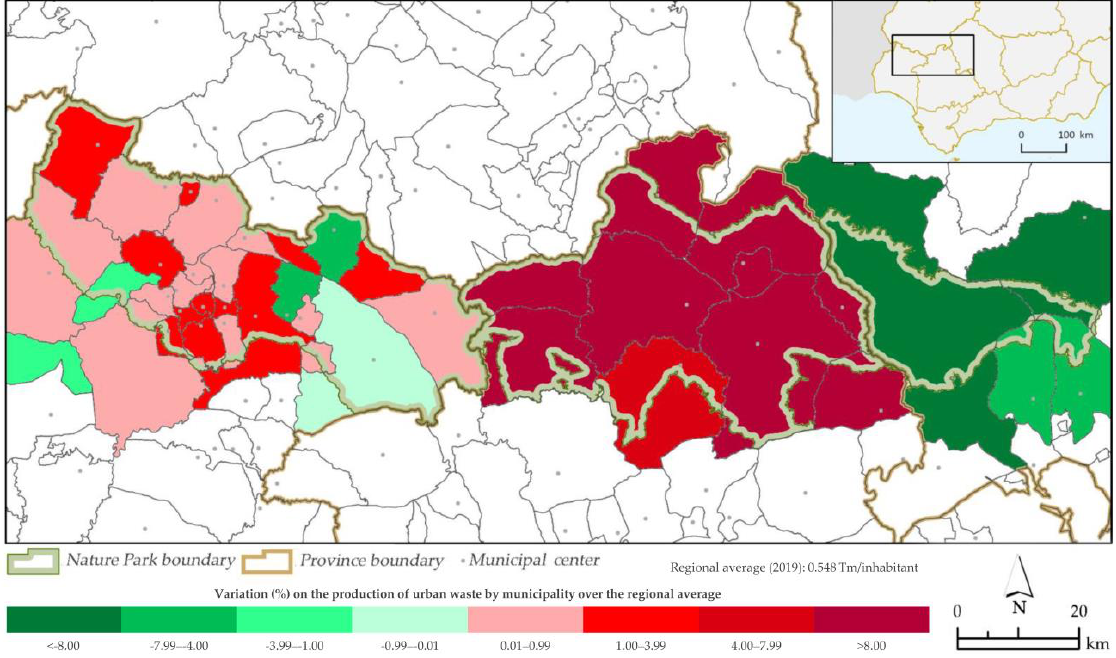
Figure 9. Urban waste generated in the study area (2019). Source: [85]; authors ’ elaboration.